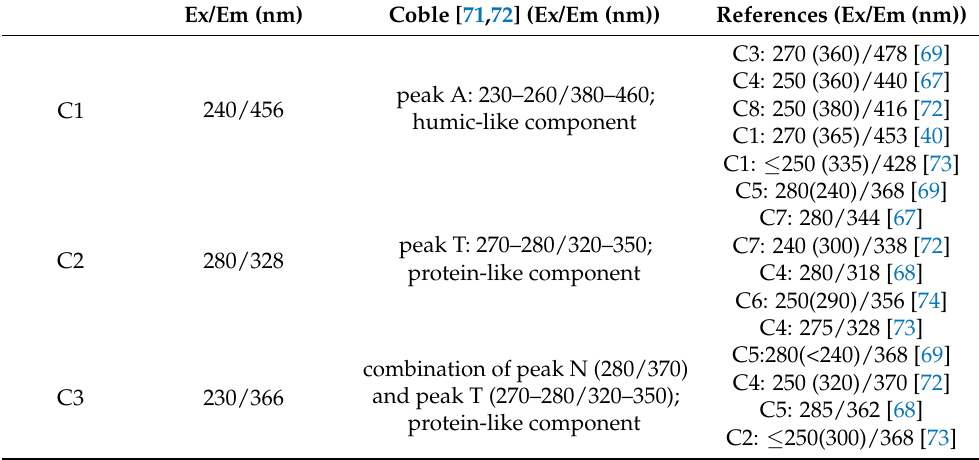
Table 2. Characteristics of the chromophoric dissolved organic matter (CDOM) components deter- mined using the parallel factor analysis (PARAFAC) model in this study and comparison with the results of previous